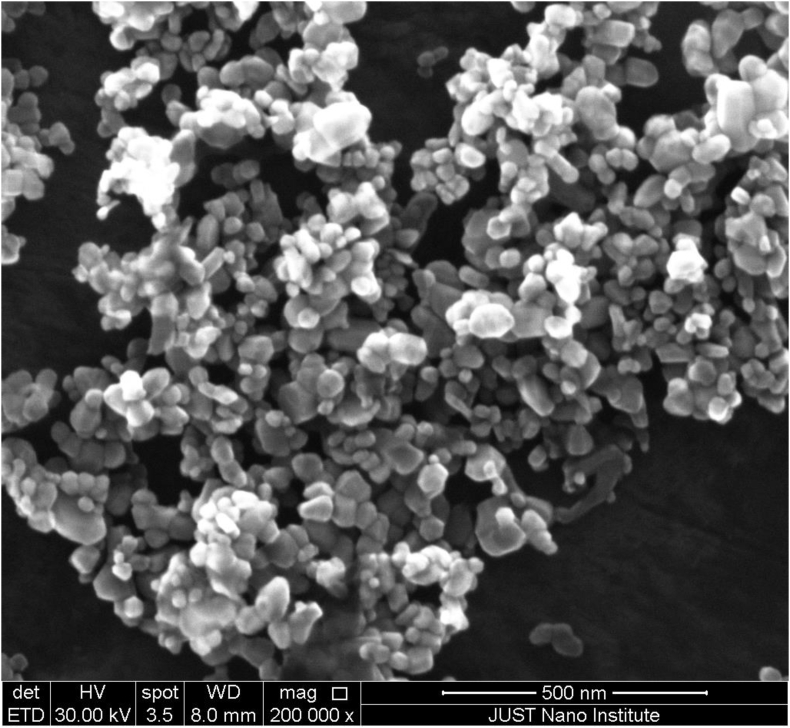
SEM image of Zinc oxide nanoparticles.